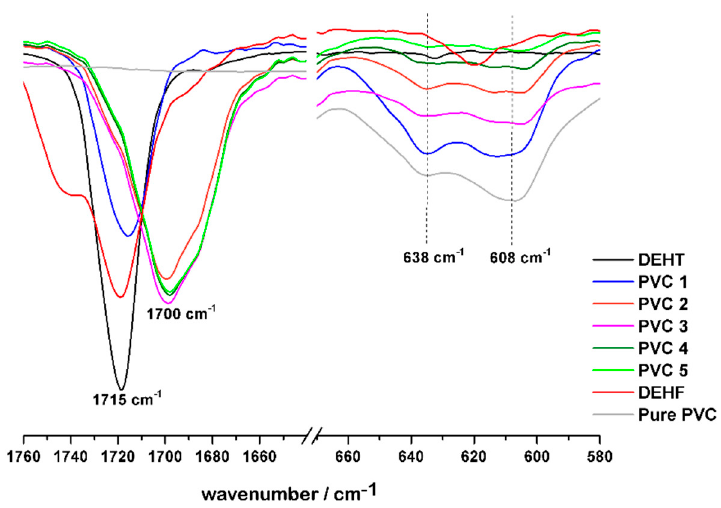
Figure 2. ATR FTIR spectra of all PVC-DEHF/DEHT blends in the C=O and C–Cl stretching regions.